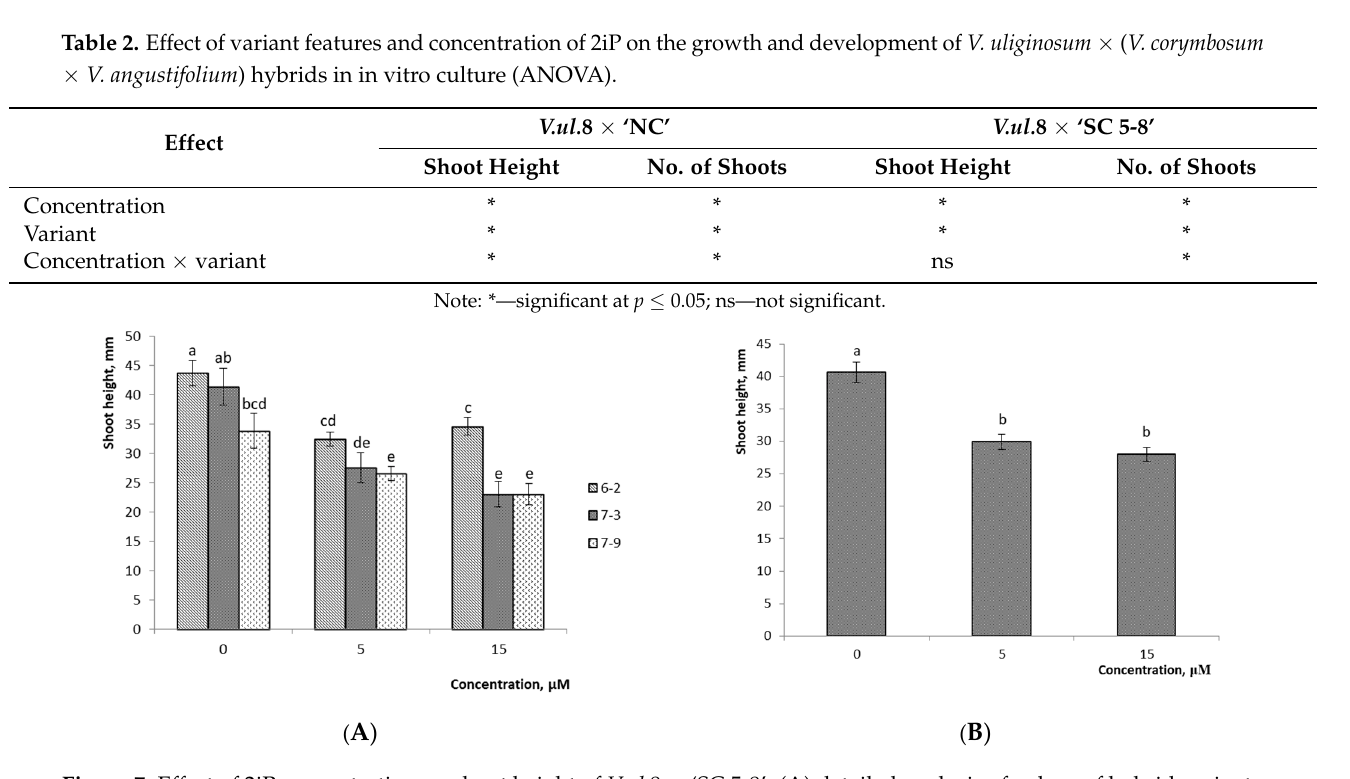
Figure 7. Effect of 2iP concentration on shoot height of V.ul. 8 × ‘SC 5-8’: ( A ) detailed analysis of values of hybrid variants; ( B ) average values of hybrid variants. Means followed by the same letter are not significantly different according to the LSD at p ≤ 0.05. Note: 6-2, 7-3, 7-9—variant Nos. 6-2, 7-3, 7-9. Table 3. Growth parameters of V. uliginosum × ( V. corymbosum × V. angustifolium ) hybrids after 2 years of cultivation.